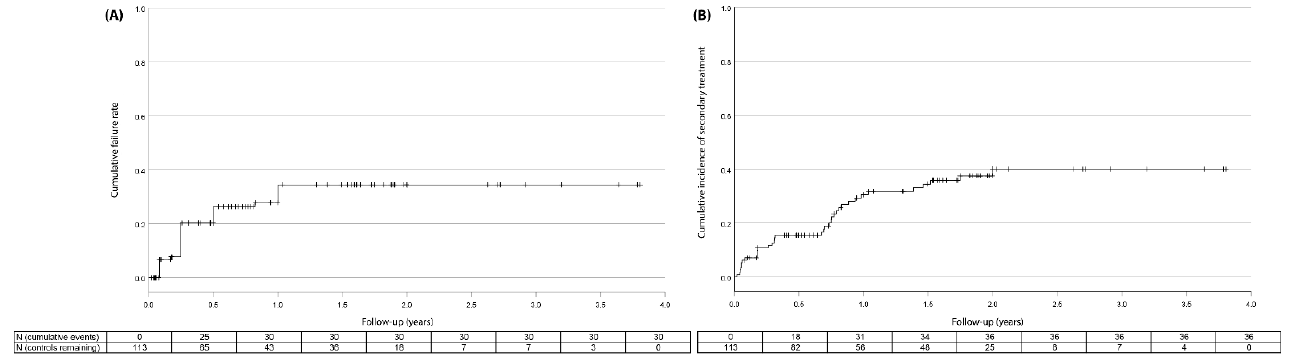
Figure 3. Kaplan–Meier cumulative incidence curve for failure defined as <20% reduction in IOP ( A ) and for secondary treatment ( B ). Censored patients are denoted by vertical tick marks. The Tables represent the total cumulative incidence.